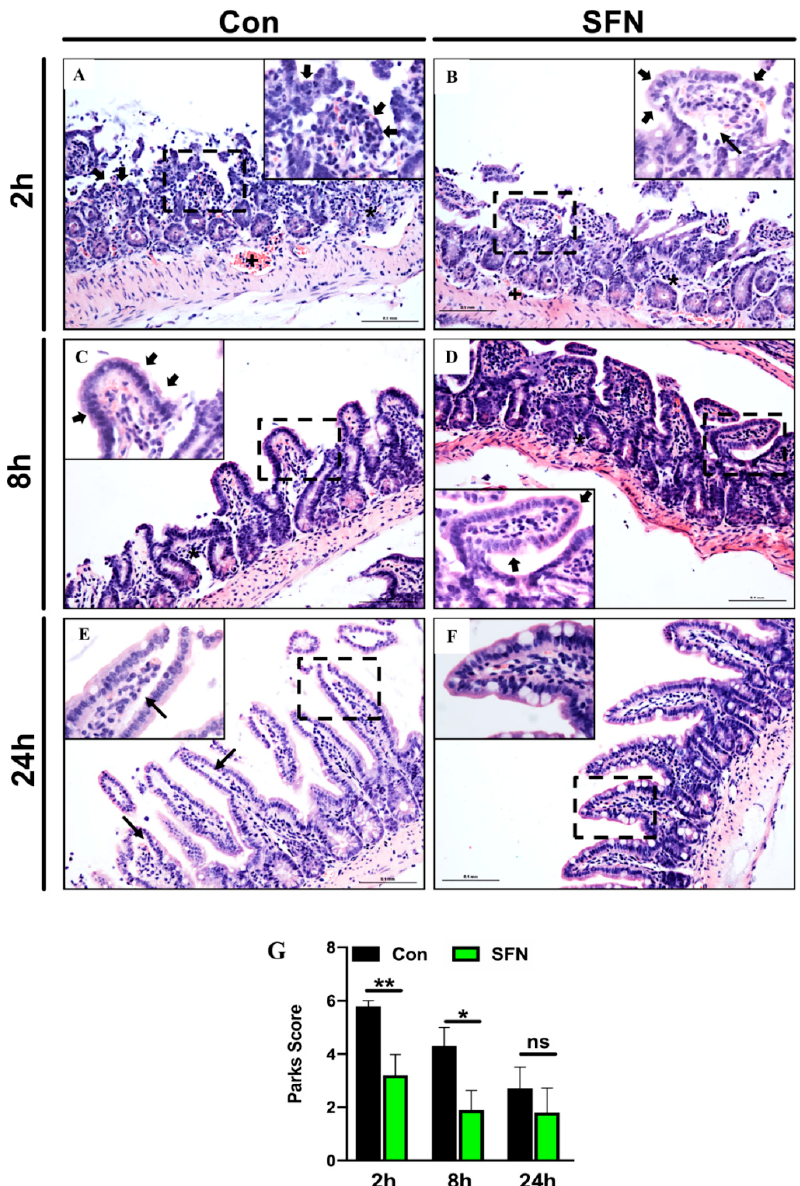
Figure 1. ( A – F ) Representative histopathologic images of hematoxylin and eosin (H&E) stained cross sections showing IRI-induced morphological damage in the murine intestine of control (CON) and SFN-treated animals (SFN). ( G ) Park/Chiu score comparing comparing control (CON) and SFN-treated animals (SFN) after 2 h, 8 h and 24 h of reperfusion. Overview images were taken at × 20 magnification, insets (dashed square in the overview image) at × 40 magnification, scale bar 0.1 mm. Black asterix showing submucosal mixed inflammatory cell infiltrate, black cross showing dilated capillaries, filled black arrows indicate epithelium lining at the top of villi and small black arrows indicate extension of the subepithelial space. All data are presented as mean values ± SEM. n = 10 mice per group. Significance is indicated by the following symbols: * = p < 0.05, ** = p < 0.01 versus Con, ns = not significant .